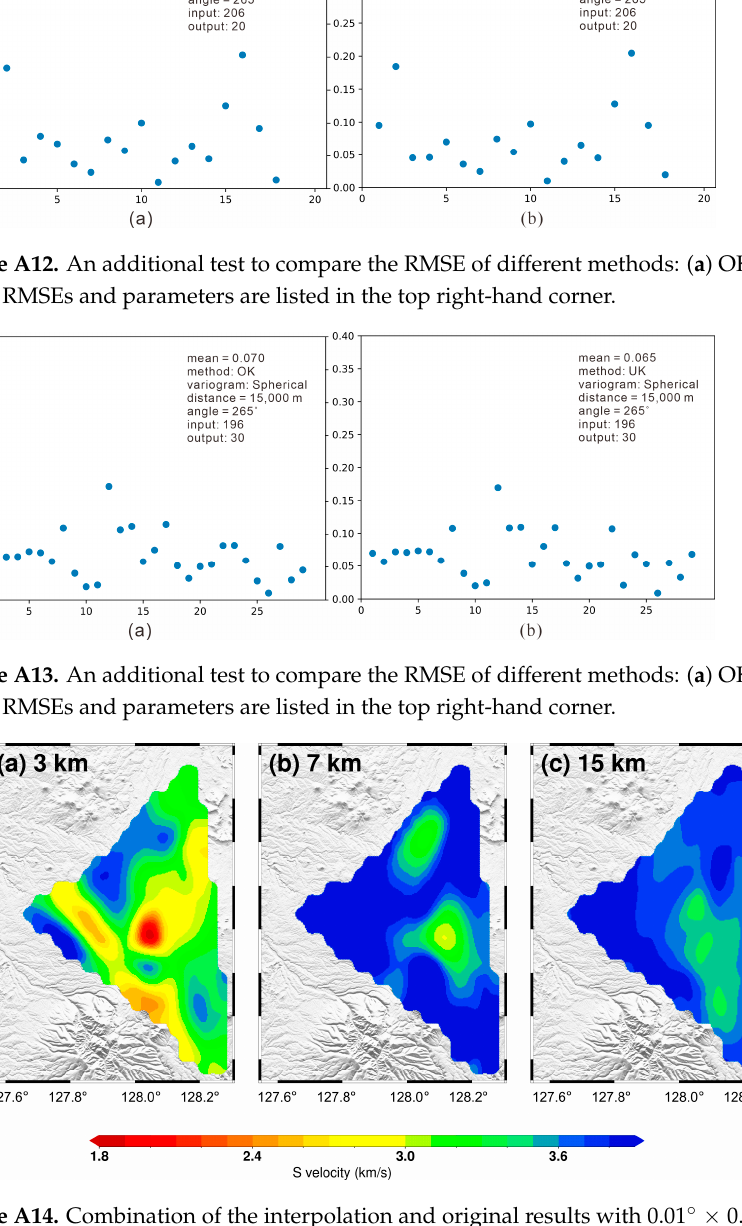
Figure A15. Original results imaged by 0.01° × 0.01° grid at different depths. References 1.